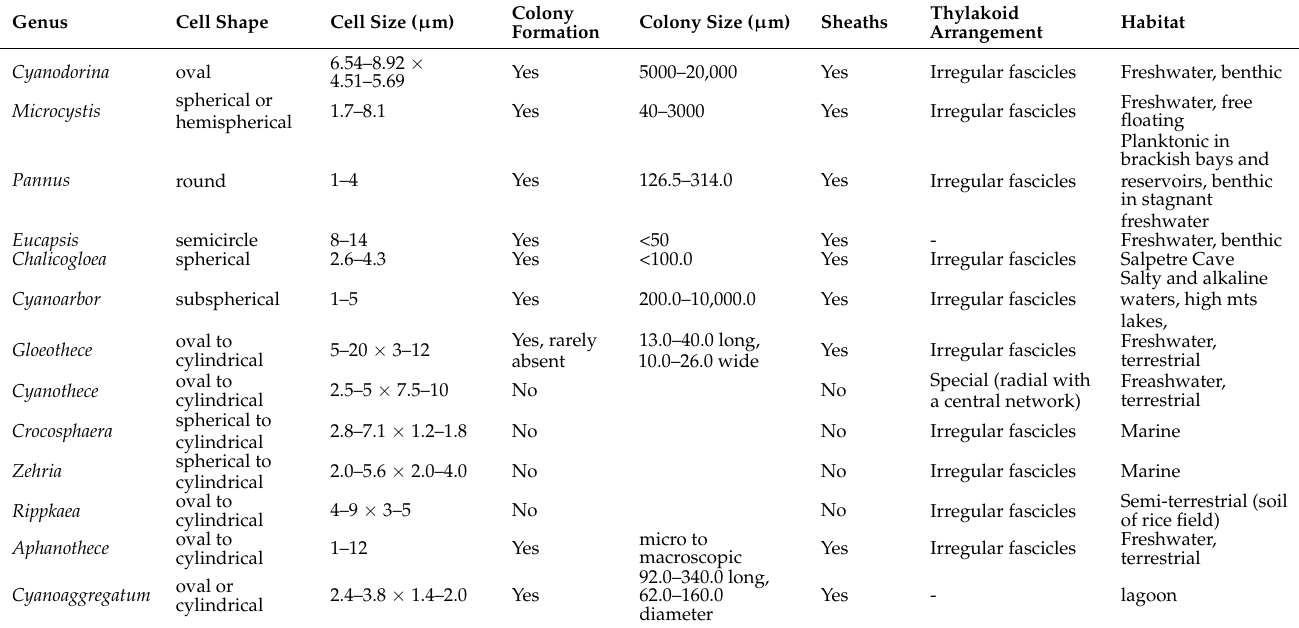
Table 3. Comparison of the characteristics of the 13 previously described genera of Chroococcales (“-” indicates that the feature is